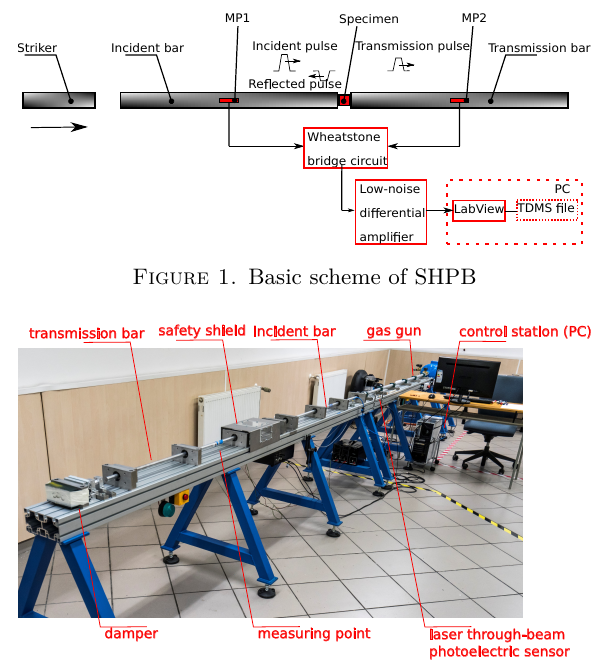
Figure 2. Loading device overview